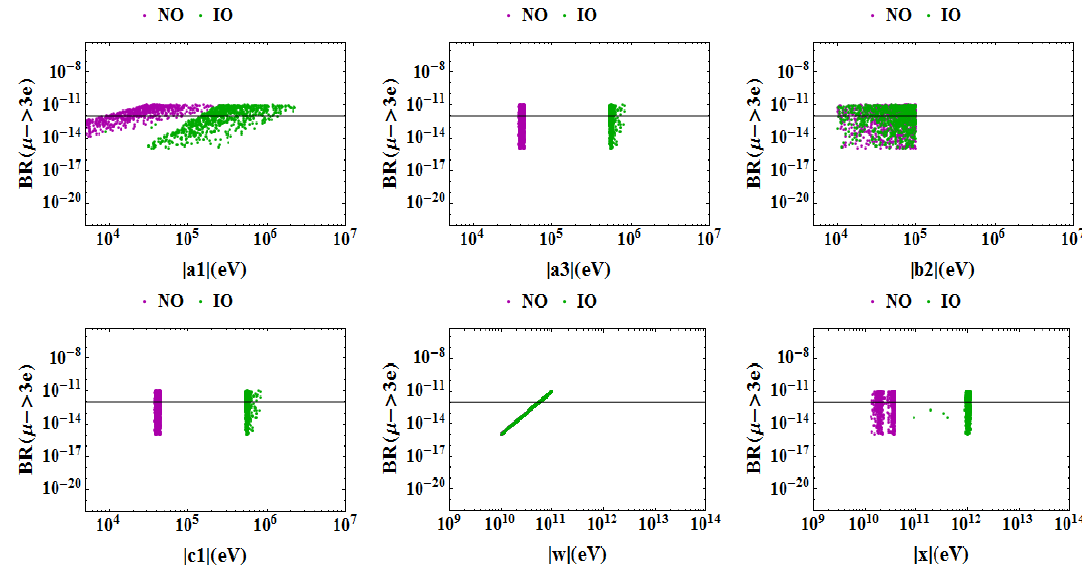
Figure 30 . BR for (cid:22) ! 3e as a function of model parameters for the class B1. The horizontal line represents the upper limit for BR given by SINDRUM experiment.